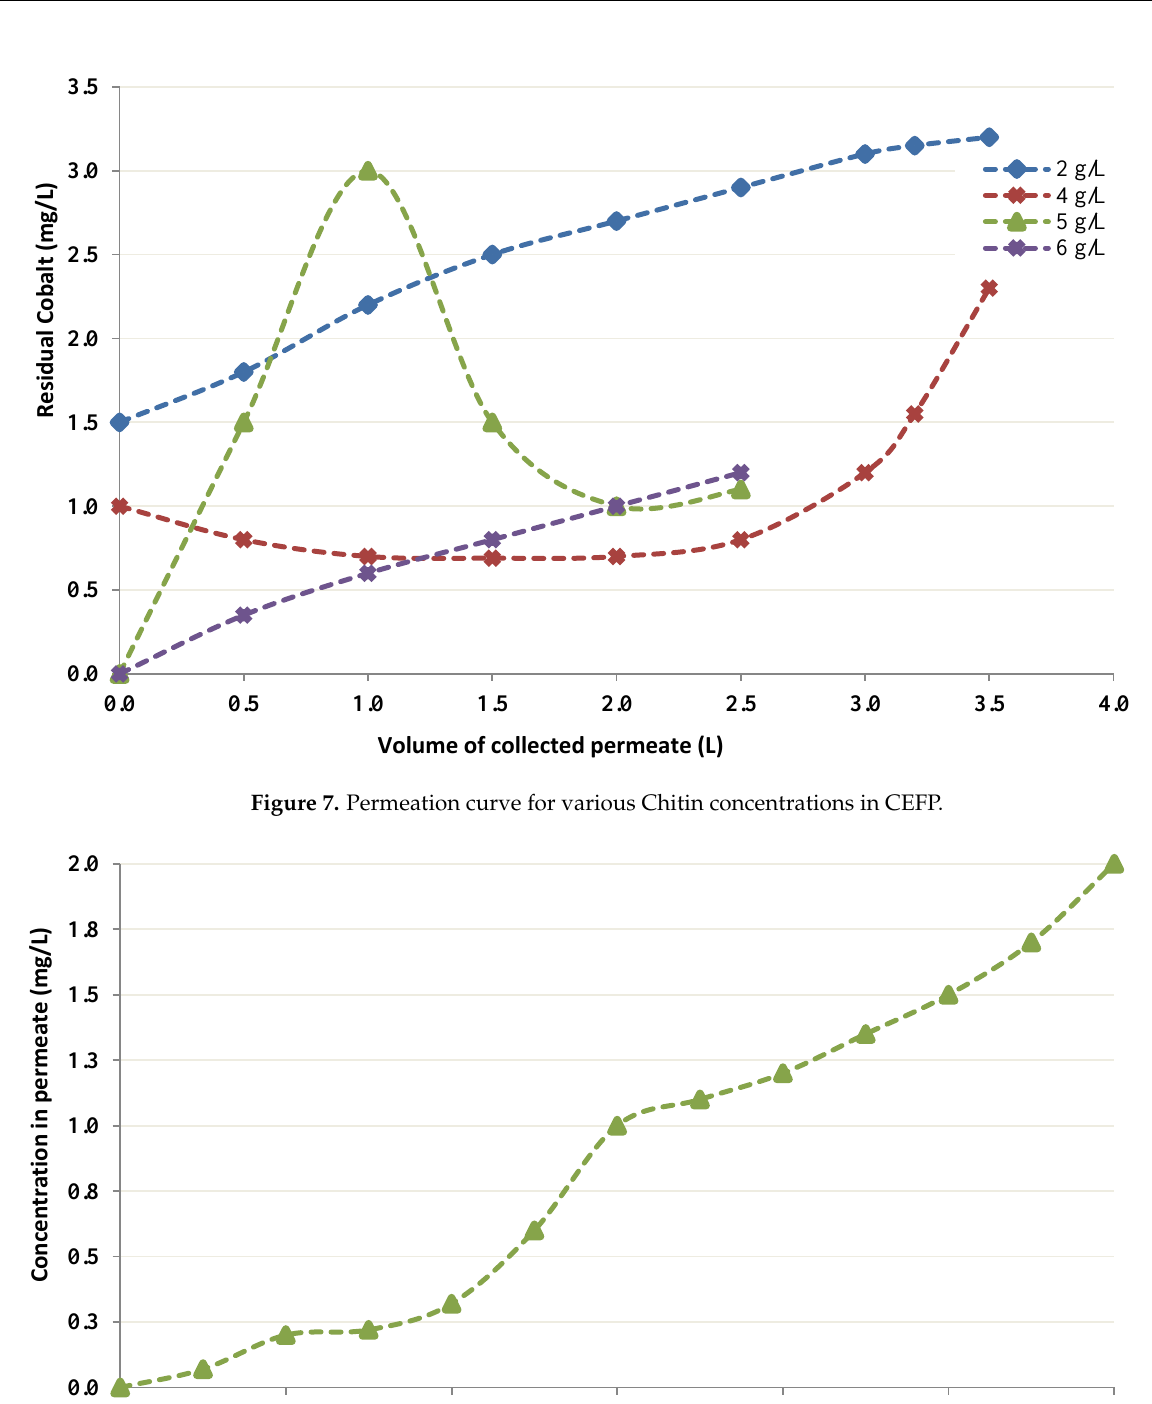
Figure 8. Permeation curve illustrating CEFP with 6 g/L chitin (volume of 20 mg/L Cobalt was 3 L, and pH =